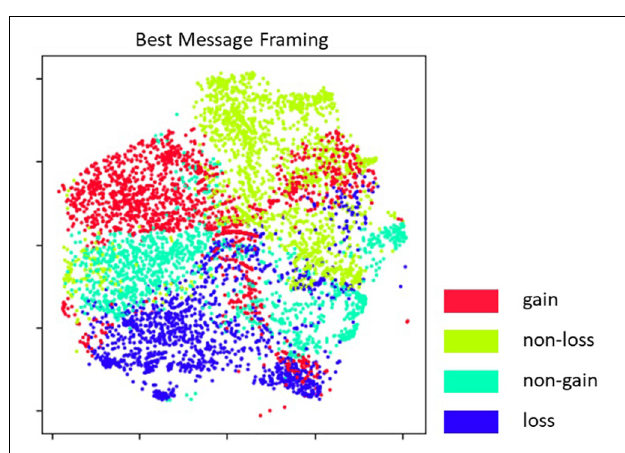
FIGURE 4 | Clusters of individuals by the most effective message framing. Spatial positioning of the simulated population is the same as in the previous